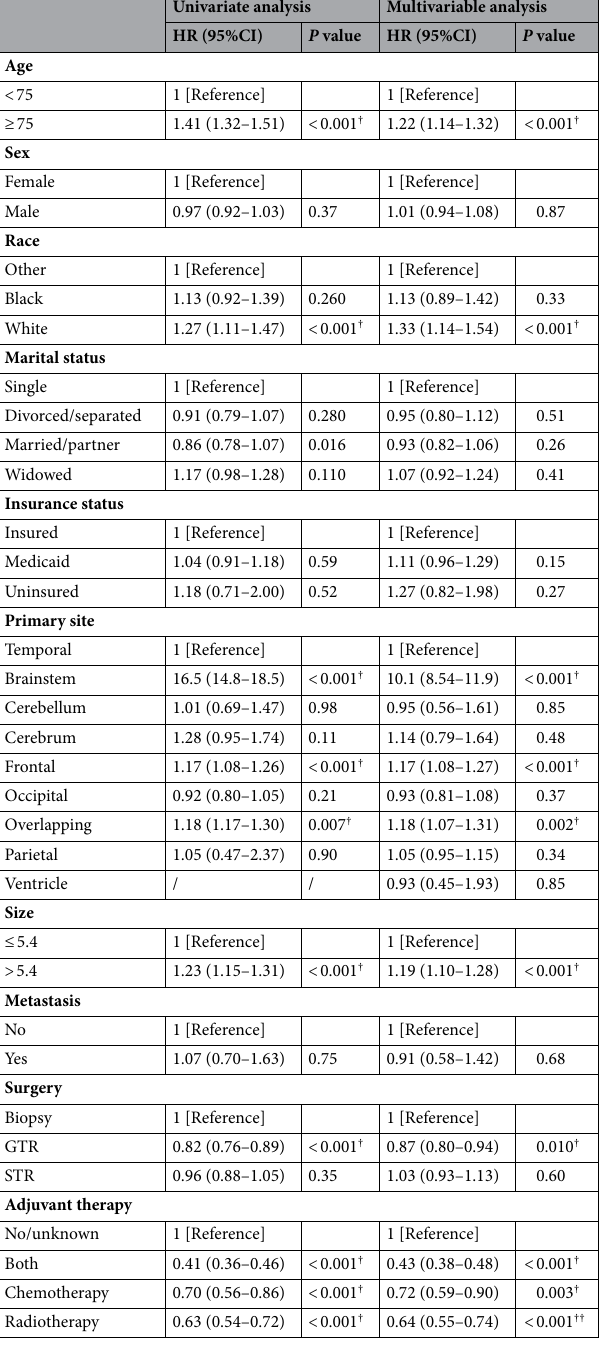
Table 3. Univariate and multivariable competing risk analyses for GBM related death in elderly patients with glioblastoma. GTR gross total resection, STR subtotal resection. † P < 0.05, statistically